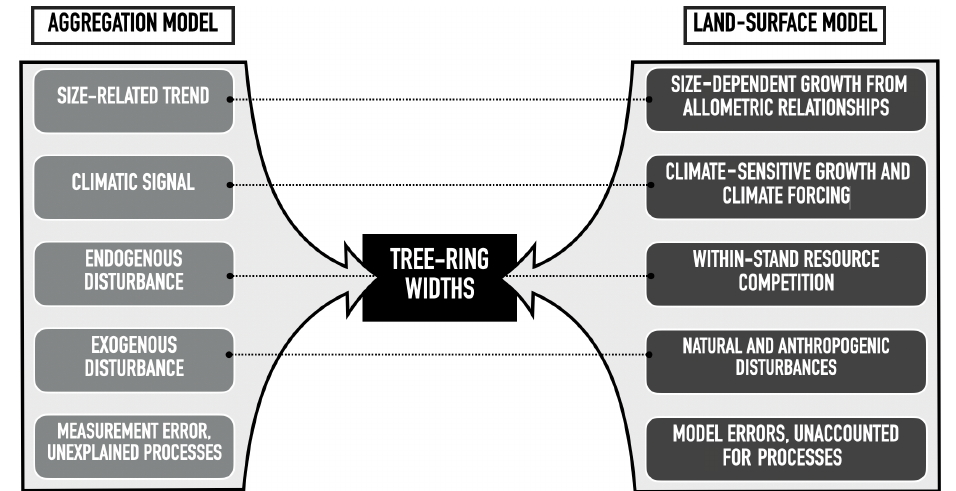
Figure 2. Main drivers of the linear aggregate conceptual model of tree-ring growth (Cook and Kairiukstis, 1990) and the equivalent processes in land-surface models. The dotted lines connect related components. Note that both the aggregation and the land-surface model come with errors, uncertainties, and unaccounted for processes that are not explicitly